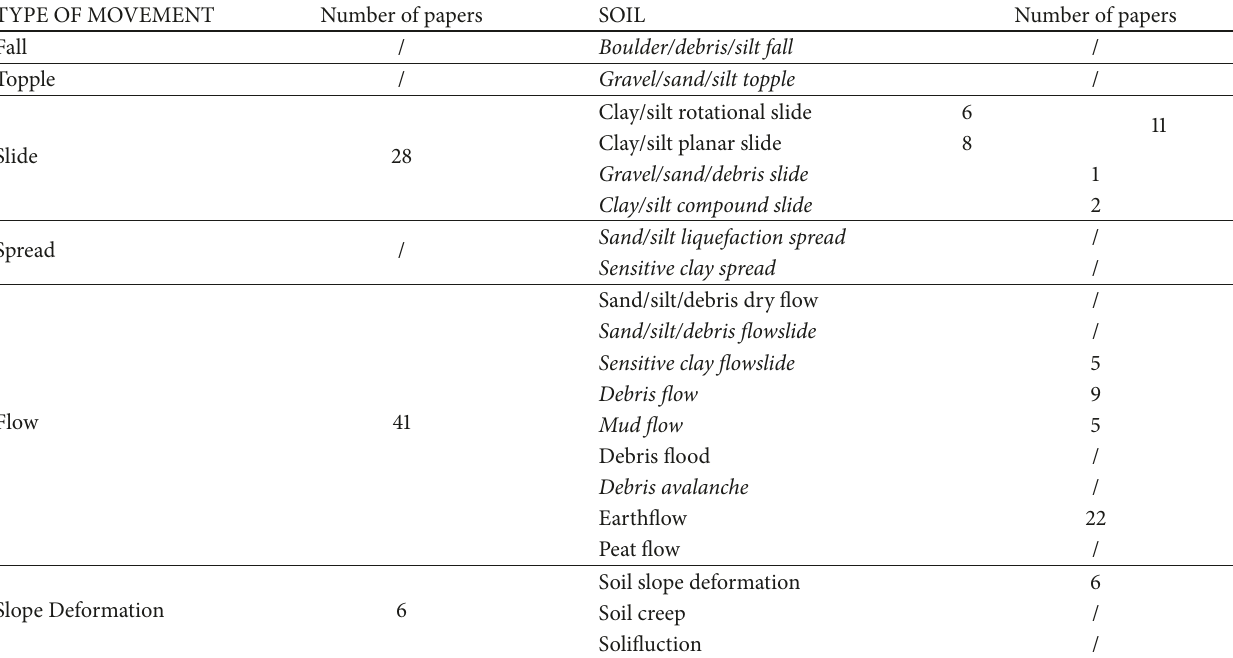
Table5:Foreachtypeofmovementand“soil”landslidetypology,thetablesummarizeshowmanypapersarefocusedonit.Initalicmovement types that usually reach extremely rapid velocities as defined by [2], while for the others, the velocity varies between extremely slow to very rapid (for details, refer to